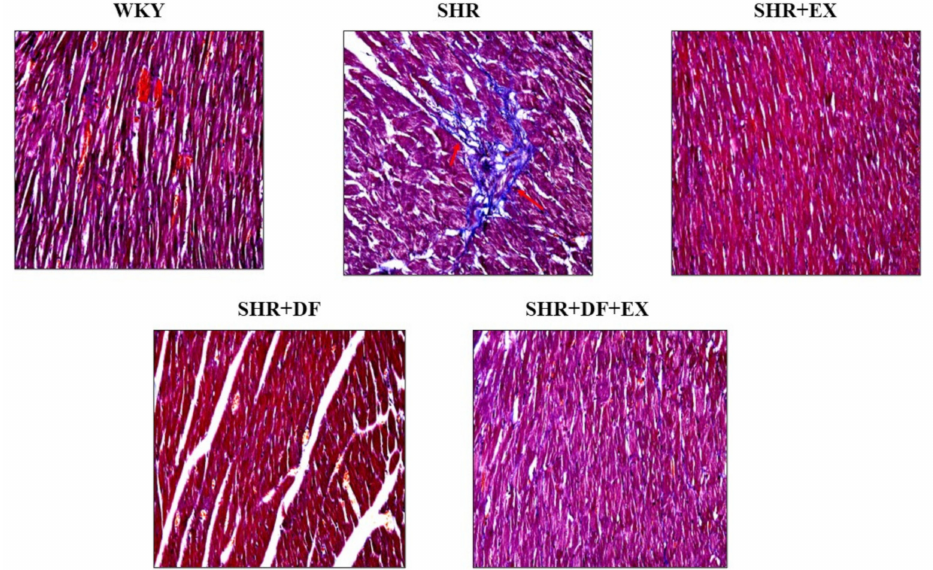
Figure 6. Effects of DF peptide treatment and exercise in cardiac fibrosis. Masson Trichrome